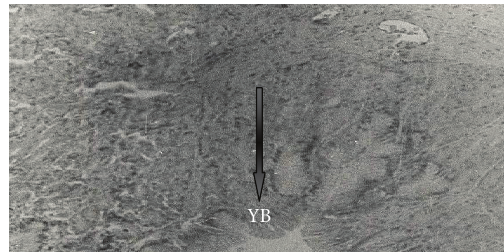
Figure 11: Plate of photomicrograph of intestine of Clarias gariepinus after 12 weeks exposure to 22ppb of gammalin 20 showed yellow bodies (YB) at the lamina propria of the mucosal fold.